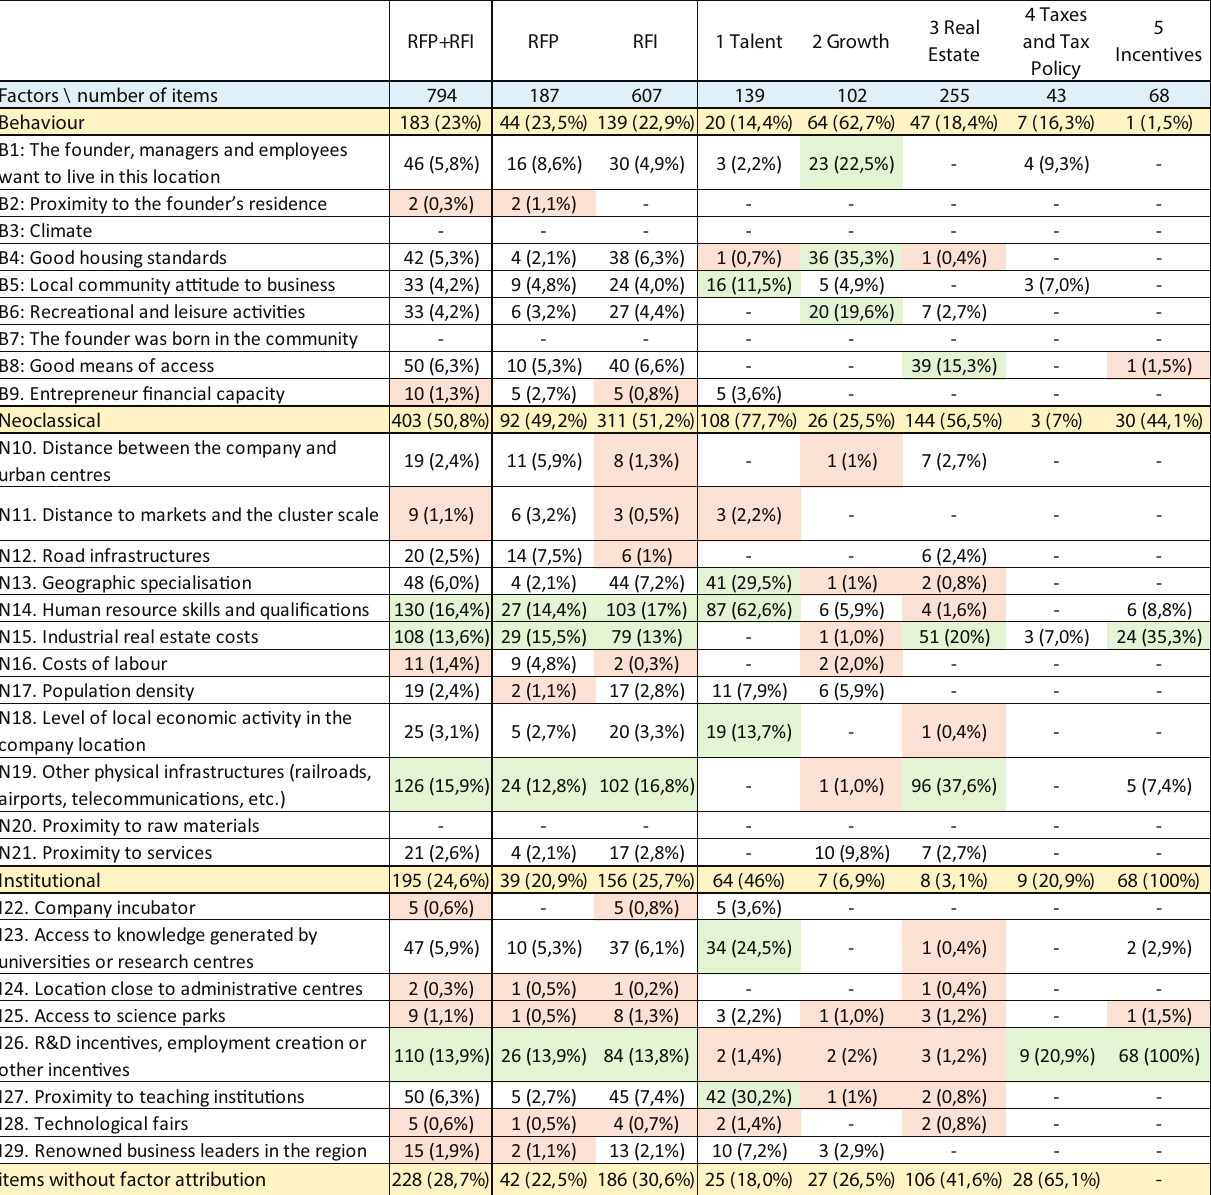
Figure 6. Analysis of location factors attributed to Amazon’s HQ2 location decision